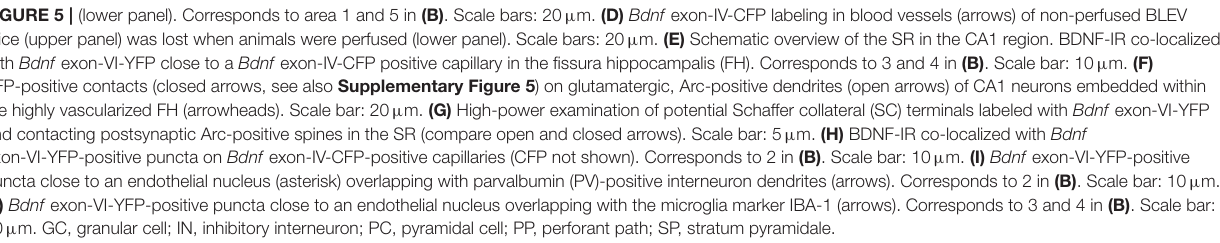
FIGURE 5 | (lower panel). Corresponds to area 1 and 5 in (B) . Scale bars: 20 µ m. (D) Bdnf exon-IV-CFP labeling in blood vessels (arrows) of non-perfused BLEV mice (upper panel) was lost when animals were perfused (lower panel). Scale bars: 20 µ m. (E) Schematic overview of the SR in the CA1 region. BDNF-IR co-localized with Bdnf exon-VI-YFP close to a Bdnf exon-IV-CFP positive capillary in the fissura hippocampalis (FH). Corresponds to 3 and 4 in (B) . Scale bar: 10 µ m. (F) YFP-positive contacts (closed arrows, see also Supplementary Figure 5 ) on glutamatergic, Arc-positive dendrites (open arrows) of CA1 neurons embedded within the highly vascularized FH (arrowheads). Scale bar: 20 µ m. (G) High-power examination of potential Schaffer collateral (SC) terminals labeled with Bdnf exon-VI-YFP and contacting postsynaptic Arc-positive spines in the SR (compare open and closed arrows). Scale bar: 5 µ m. (H) BDNF-IR co-localized with Bdnf exon-VI-YFP-positive puncta on Bdnf exon-IV-CFP-positive capillaries (CFP not shown). Corresponds to 2 in (B) . Scale bar: 10 µ m. (I) Bdnf exon-VI-YFP-positive puncta close to an endothelial nucleus (asterisk) overlapping with parvalbumin (PV)-positive interneuron dendrites (arrows). Corresponds to 2 in (B) . Scale bar: 10 µ m.